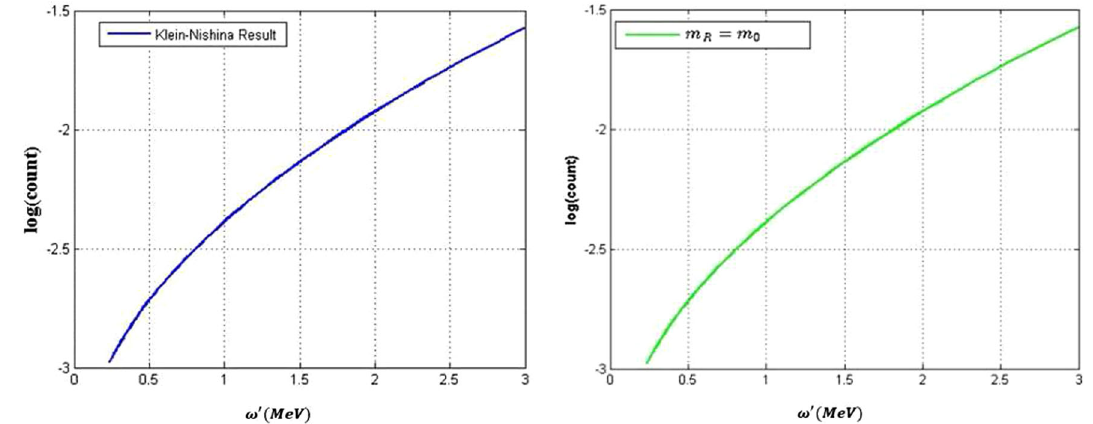
Fig. 1 Energy distribution of scattered photons ω (cid:7) : Klein–Nishina formula (left), our result with m R = m 0 (right)